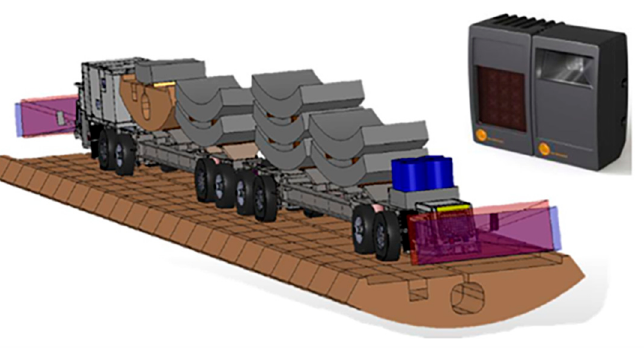
Figure 5. Camera 3D–Infrared light emitting sensor, which allows a detection distance of 50–70 m.